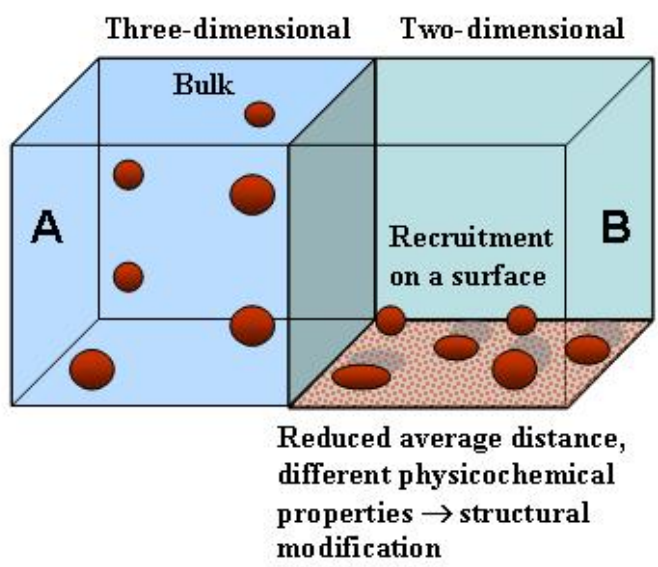
Figure 5. Distribution of molecules in a 3D or a 2D